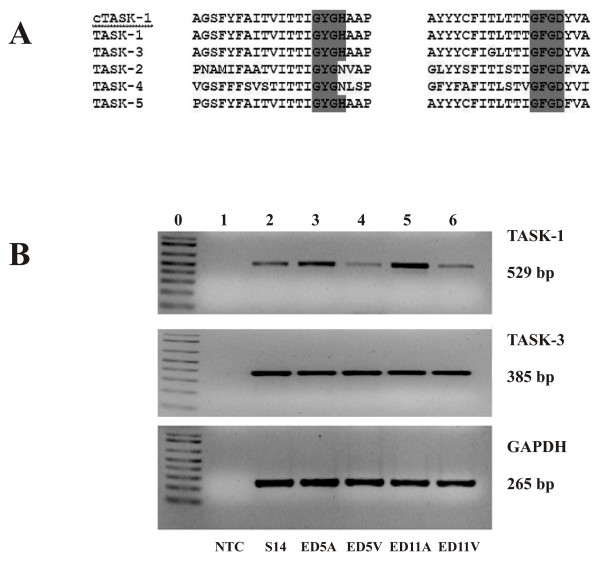
Expression of TASK-1 during chick heart development by RT-PCR. A: amino acid sequence alignment of pore regions of TASK-1 with all human TASK channels. B: TASK-1 and TASK-3 RT-PCR: Lane 0 shows 1 Kb DNA markers. Lane 1-6 as indicated at bottom (see text for definition). GAPDH expression was used as a reference and was equivalent in all samples after 25 to 40 cycle two step RT-PCR amplification. The size of cDNA products are indicated on the right hand and the developmental stages are labeled at the bottom.